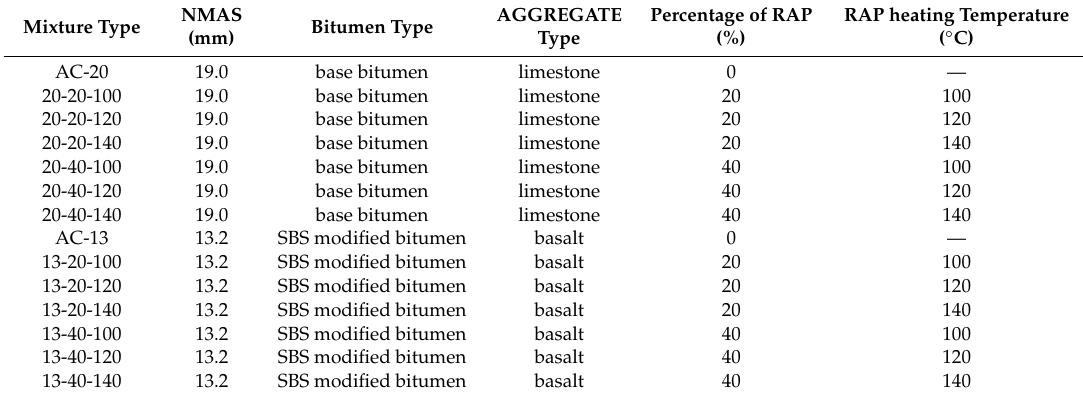
Table 1. HMA mixtures prepared for compaction